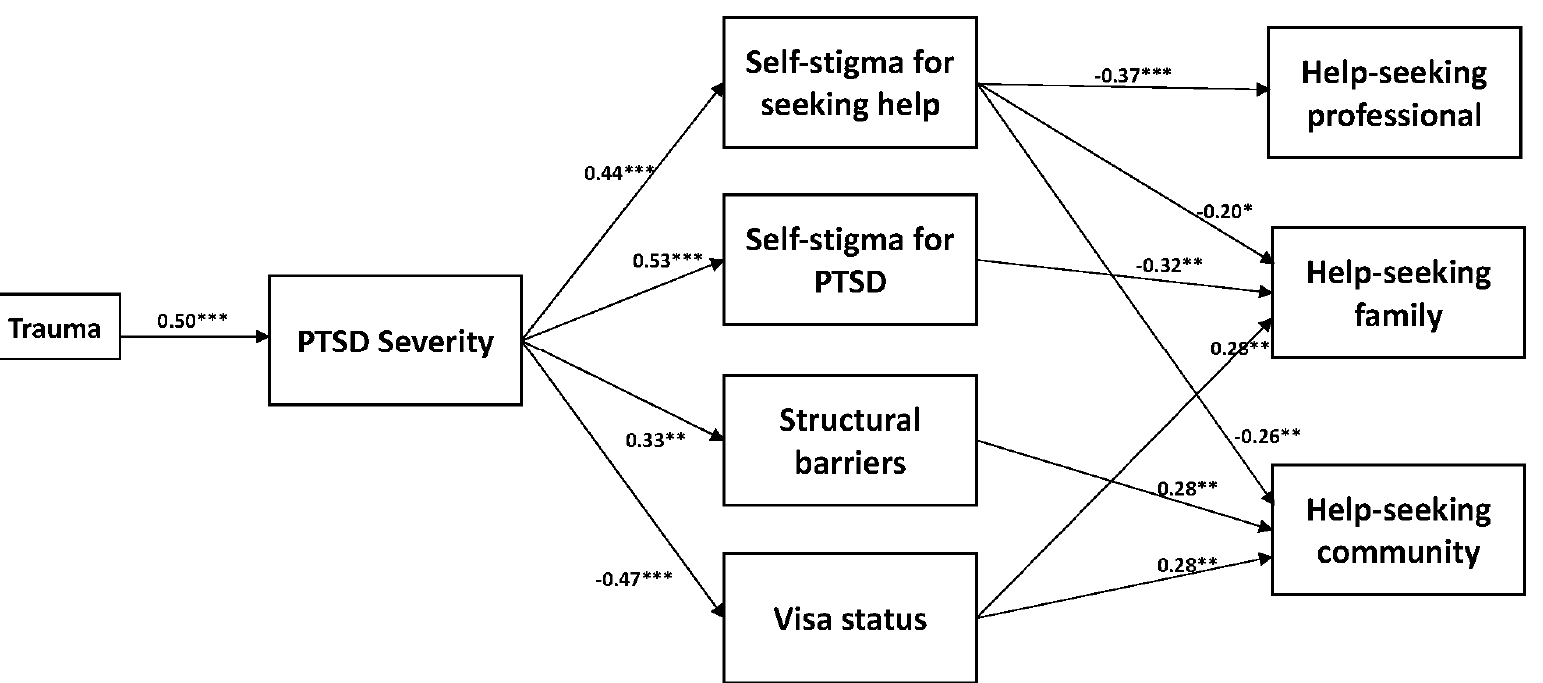
Figure 1. A schematic representing standardized effect sizes in the final reduced model, which examines the effect of PTSD severity on help-seeking via self-stigma for seeking help, self-stigma for PTSD, structural barriers, and visa status. * p < 0.05, ** p < 0.01, *** p < 0.0001.